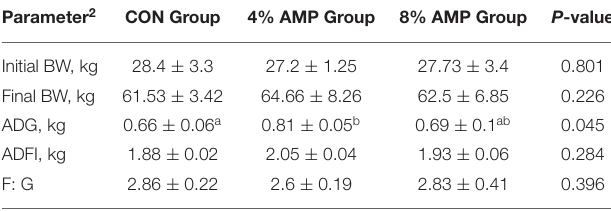
TABLE 2 | Gene name and qPCR primer sequence a . Gene Primer nucleotide sequence symbol (5’ → 3’)